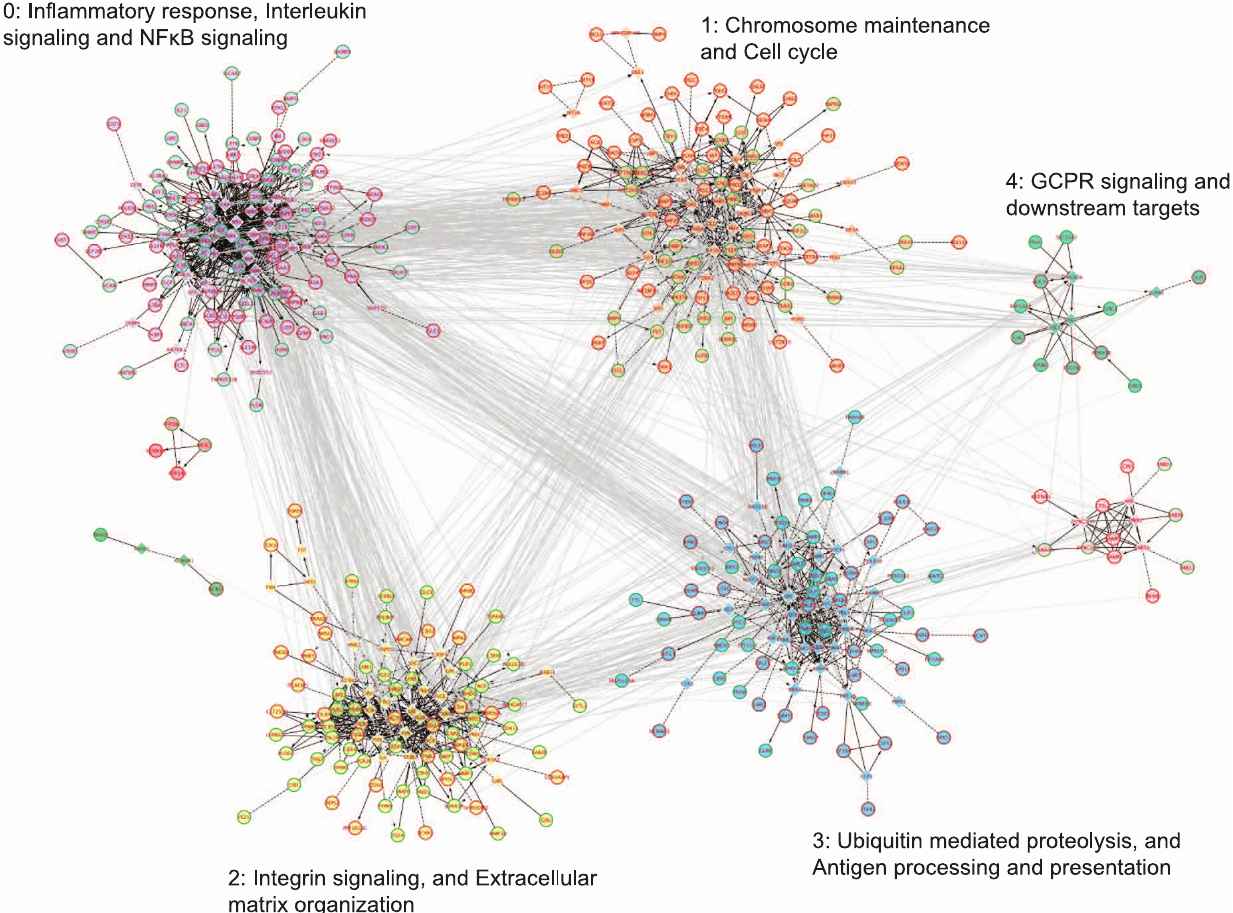
Figure 3. Network analysis of differentially expressed genes in human FTE OE-E6/E7 cells treated with DEX. Module annotations were performed with false discovery rate (FDR) , 0.05. Genes up-regulated in human FTE OE-E6/E7 cells treated with DEX are depicted by red outer circles, whereas genes down-regulated in human FTE OE-E6/E7 cells treated with DEX are depicted by green outer circles. Linker genes are depicted as diamond shaped nodes. Direct activating or inhibitory interactions are indicated with the symbols R and -|, respectively. Indirect interactions involving additional proteins are depicted with dashed lines. doi:10.1371/journal.pone.0097997.g003 PLOS ONE |